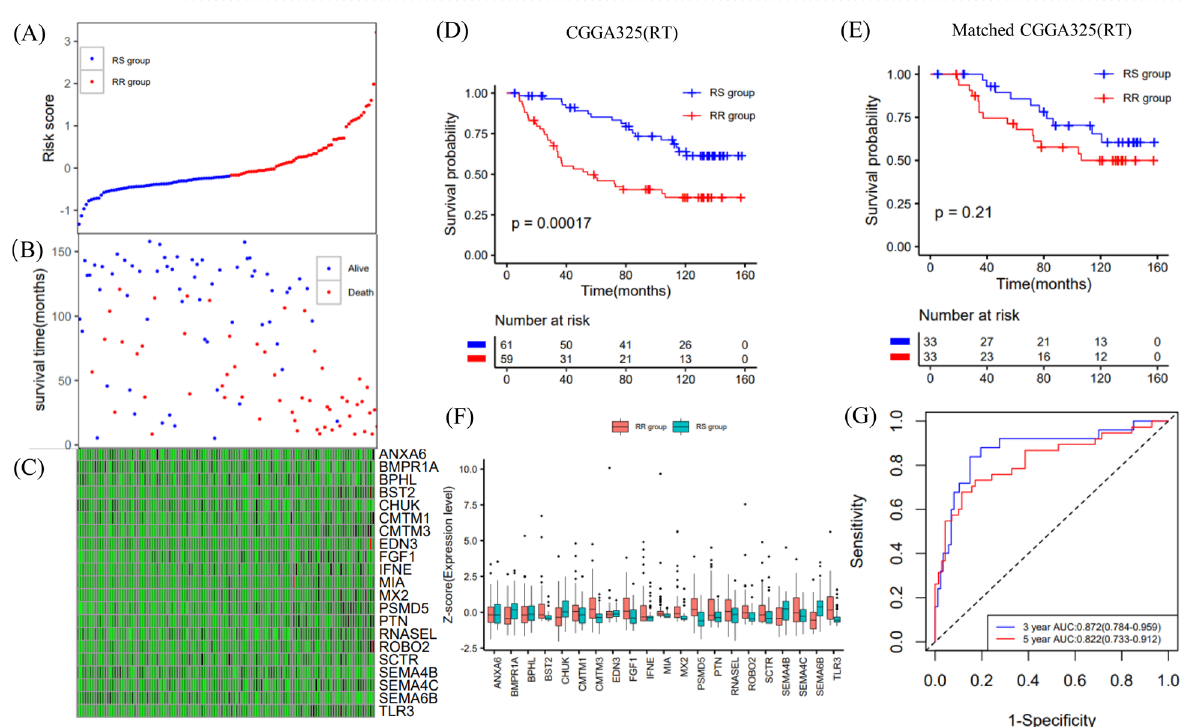
Figure 5. Validation of the OS prediction model based on 21 genes in the CGGA325 dataset. ( A , B ) The risk score, survival time of each sample. ( C ) Heatmap of 21 genes. ( D , E ) Survival curve of the RS group and RR group in radiotherapy patients in the unmatched and matched datasets. ( F ) The gene expression profile of the two groups of radiotherapy patients. ( G ) Time ‐ dependent ROC curve for